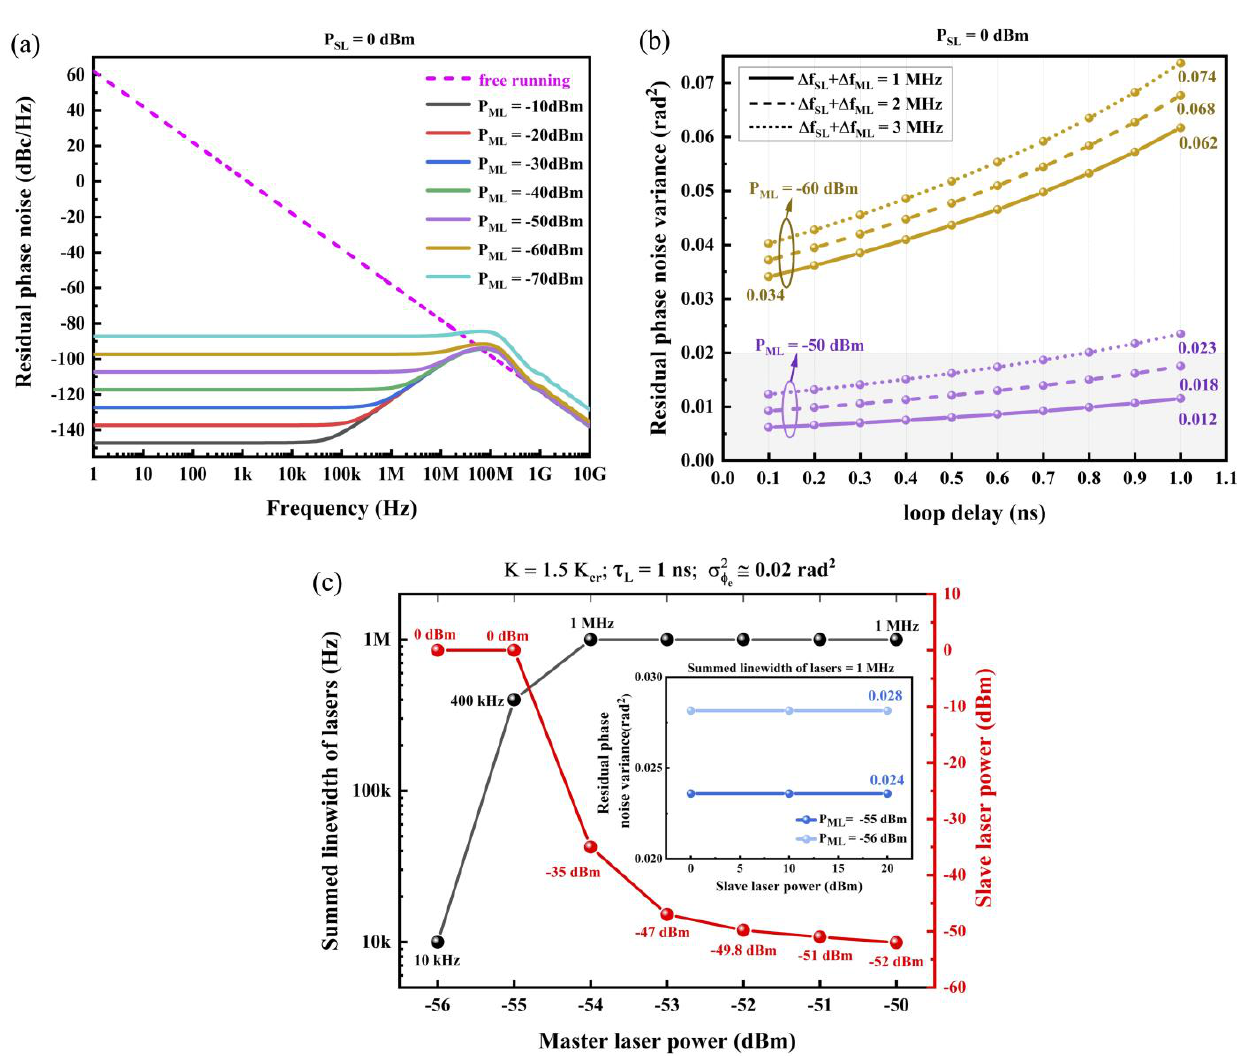
Figure 8. The influence of the laser power on the loop phase noise characteristics ( a ) the residual phase noise spectra with the different ML and same SL power; ( b ) the dependence of the residual phase noise variance on the loop delay, summed linewidth, and ML power; ( c ) the constrained relationships between these parameters with the residual phase noise variance of 0.02 rad 2 .